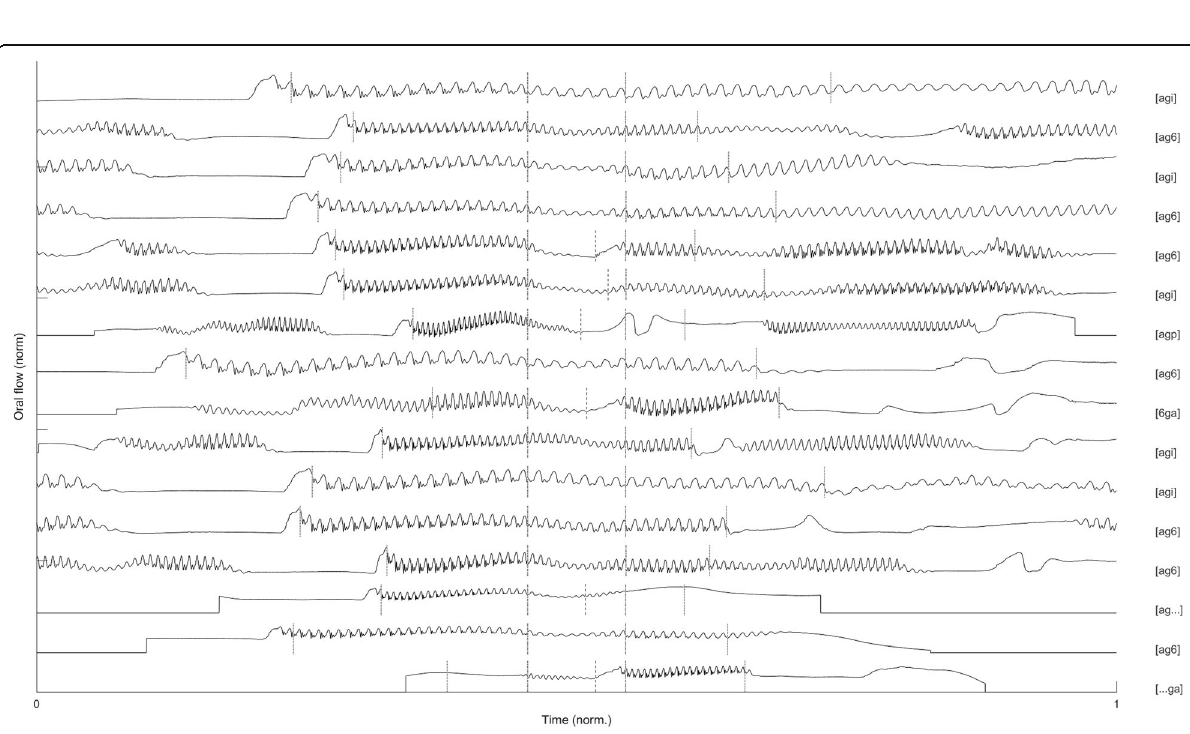
Fig. 7 Oral airflow waveforms of words with stop [ ɡ ] (16 files), produced by male speaker SP1. The dotted vertical lines indicate the start of phone1 and the end of phone3. The vertical dash-dotted lines represent the phone1 – phone2 and phone2 – phone3 boundaries where phone2 is the stop. The vertical dashed lines indicate the burst when this is discernible in either the oral airflow waveform or its spectrogram. The x- and y-axes were